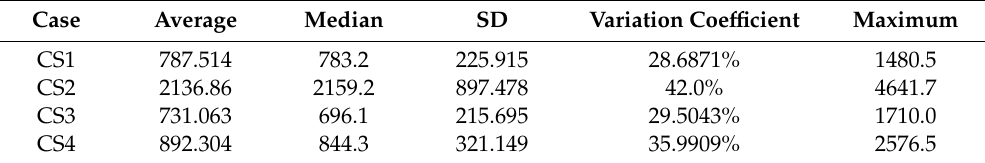
Table 7. CO 2 concentrations (ppm) before lockdown.